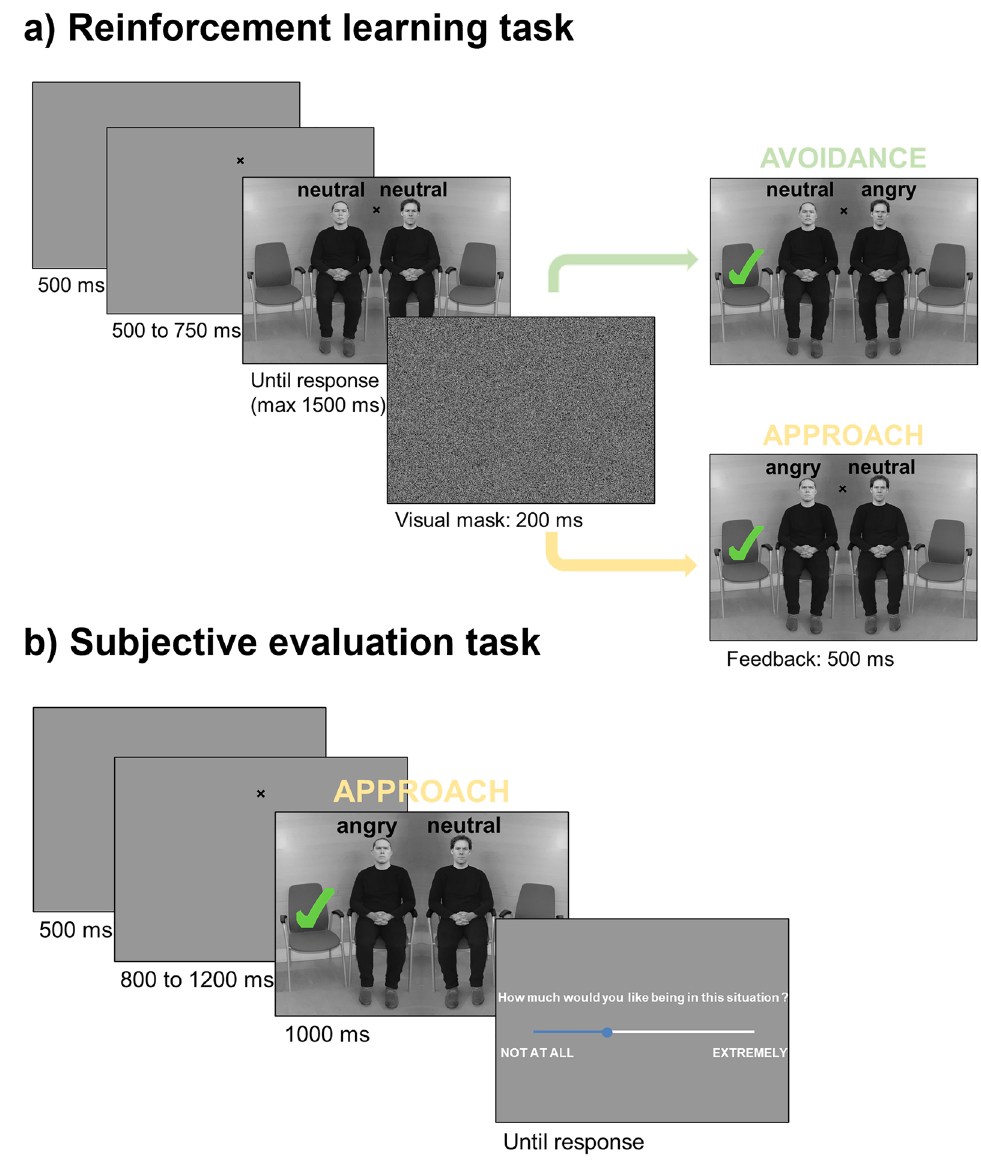
Figure 1. Behavioral tasks. ( a ) In the reinforcement learning task, participants indicated on which free chair they would like to sit, via a left/right button press. The figure shows an example trial, in which the participant pressed the left button. In the feedback phase he could find himself far from (avoidance, in green) or close to (approach, in yellow) the individual displaying anger, depending on a hidden probability associated with each chair. ( b ) In the subjective evaluation task that followed the reinforcement learning task, participants had to subjectively evaluate each possible scenario seen in the feedback phase of the previous task (the example is of an approach scenario). Please note that the identities displayed were taken from the Radboud Faces Database and were selected for illustration purposes only (they were not used for the real experiment), following the guidelines of the